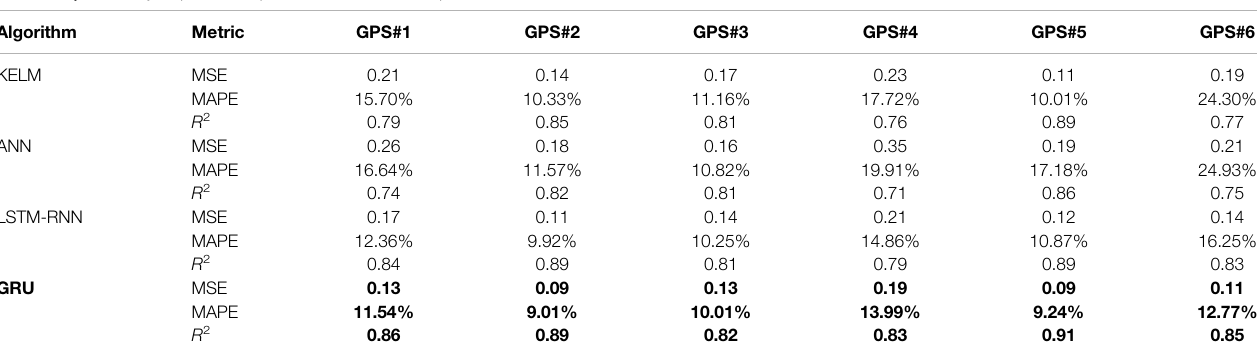
TABLE 3 | Summary of prediction performance in all GPS points